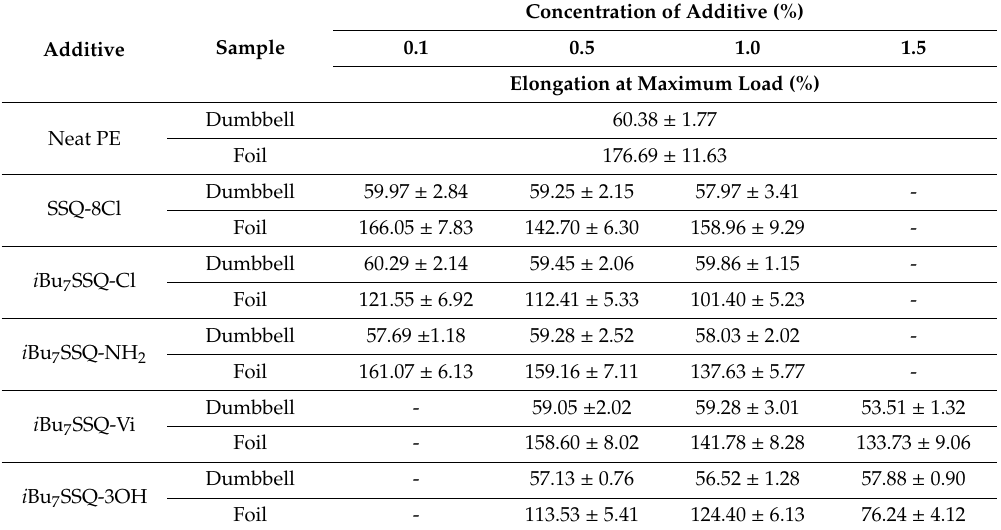
Table 3. Plastic elongation of the SSQ / PE